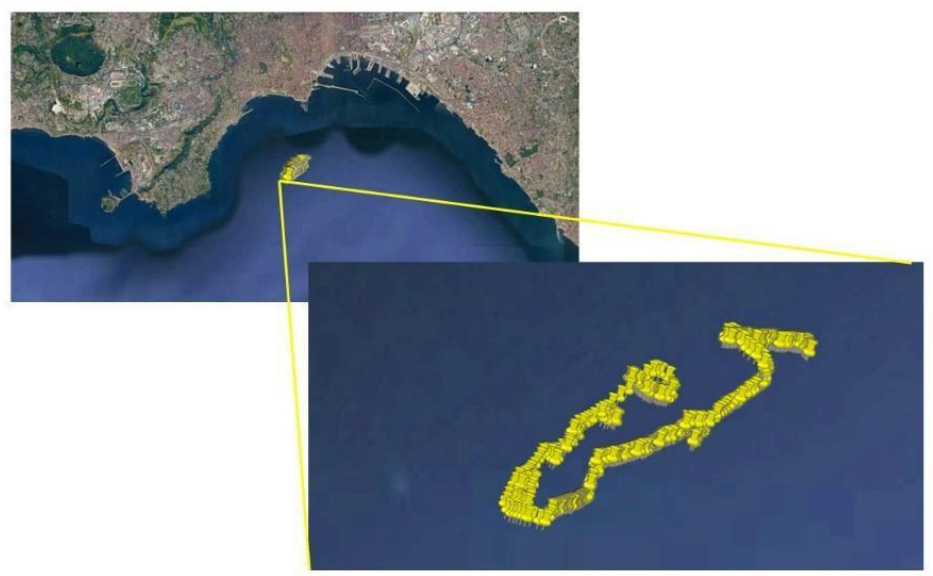
Figure 5. Trajectory travelled by the boat in the Gulf on Naples on 29 September 2021. Especially for the kinematic data collection mode, the satellite visibility and geometry must be investigated, since the boat is moving and, consequently, the characteristics of the operational context change epoch by epoch. For this analysis, data collected by the u-blox were used. The number of GPS satellites is plotted as function of time in Figure 6, while the PDOP, VDOP and HDOP values during the kinematic test are shown in Figure 7.